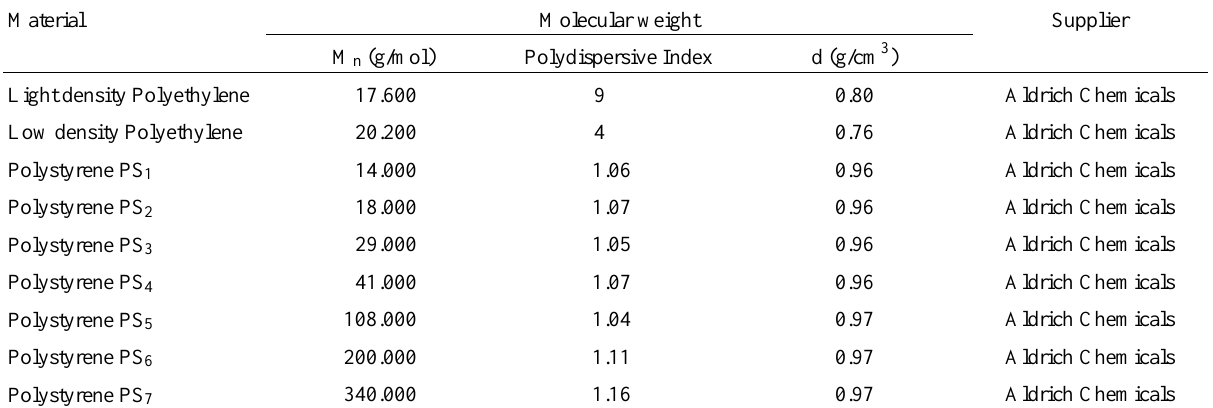
Table 1. Materials used in this